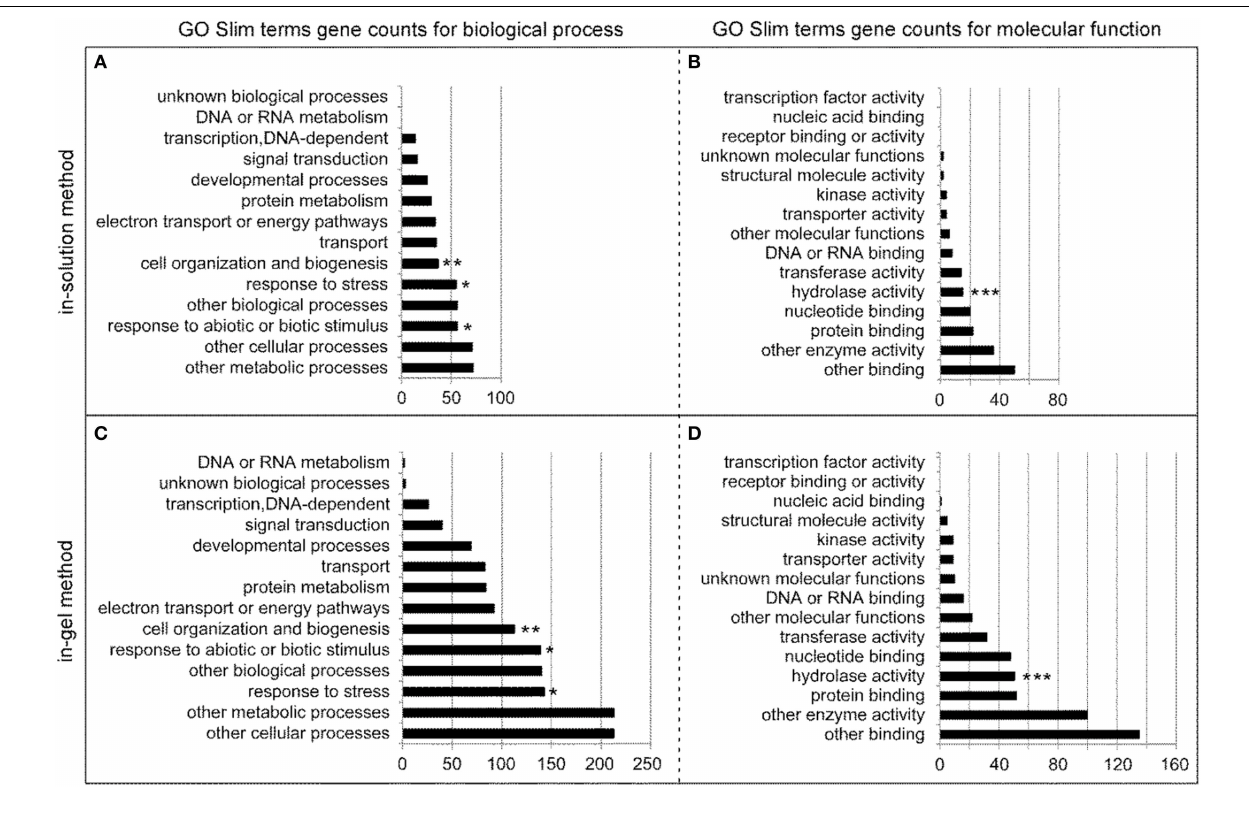
(D) of stem proteins identified by the in-gel method are illustrated in the lower two panels. Note that since GO annotation categories overlap, the sum of GO annotated genes is larger than the number of total genes analyzed. The symbols of * , ** , and *** are added in the panels to highlight the specific biologic process or molecular function, as described in details in the Results